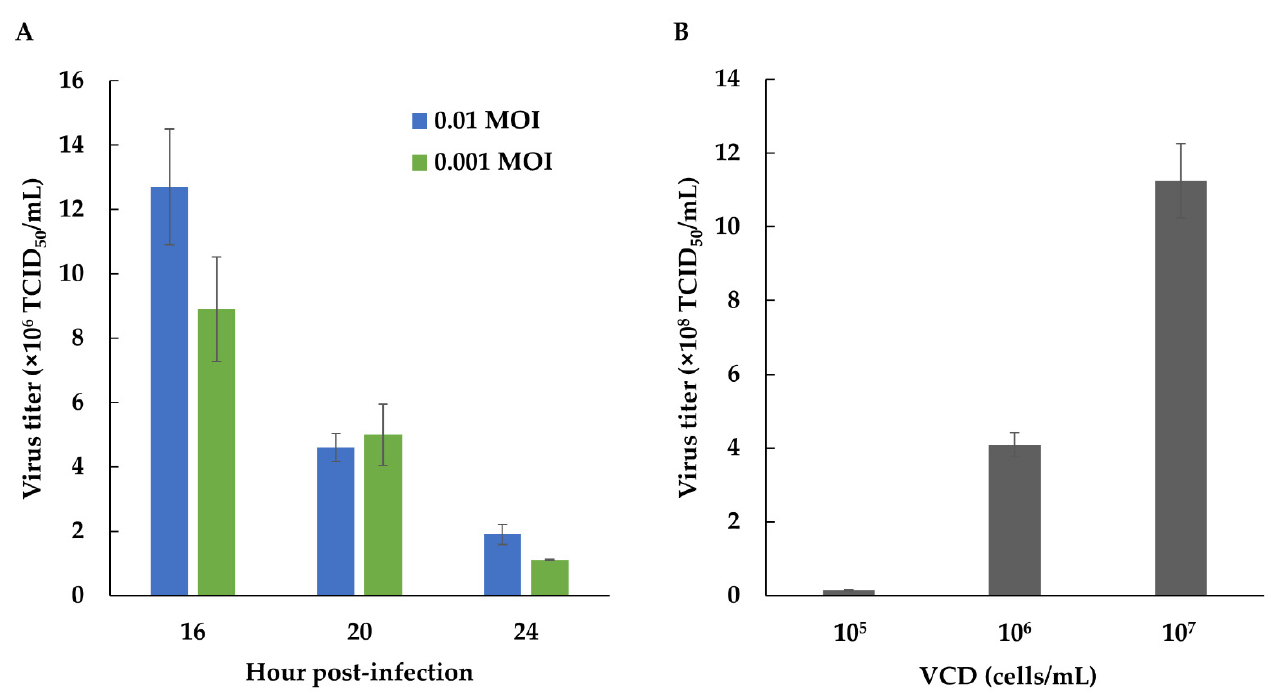
Figure 3. The sensitivity of BHK-S cells to FMDV infection was examined using FMDV MOIs of 0.01 and 0.001 ( A ). Effect of a high cell density on FMDV production ( B ). BHK-S cells were infected with an FMDV MOI of 0.01, at viable cell densities of 10 5 , 10 6 , and 10 7 cells/mL. Each experiment was carried out in triplicate. Data expressed as mean ± standard devi- ation.